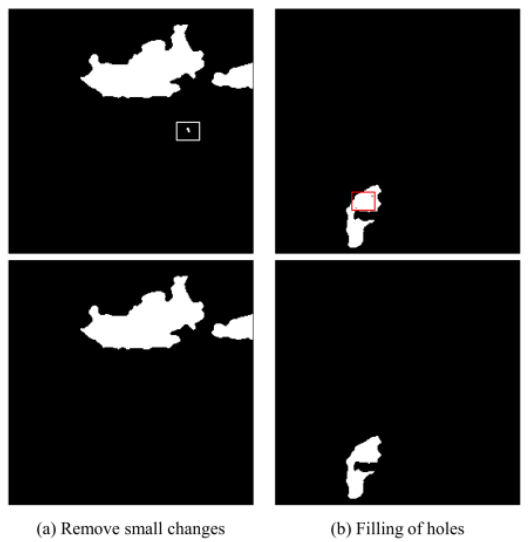
Figure 7. Post processing diagram. ( a ) Remove areas of change of less than 667 m 2 using the threshold method; ( b ) Filling of small holes in change areas using the morphological method.